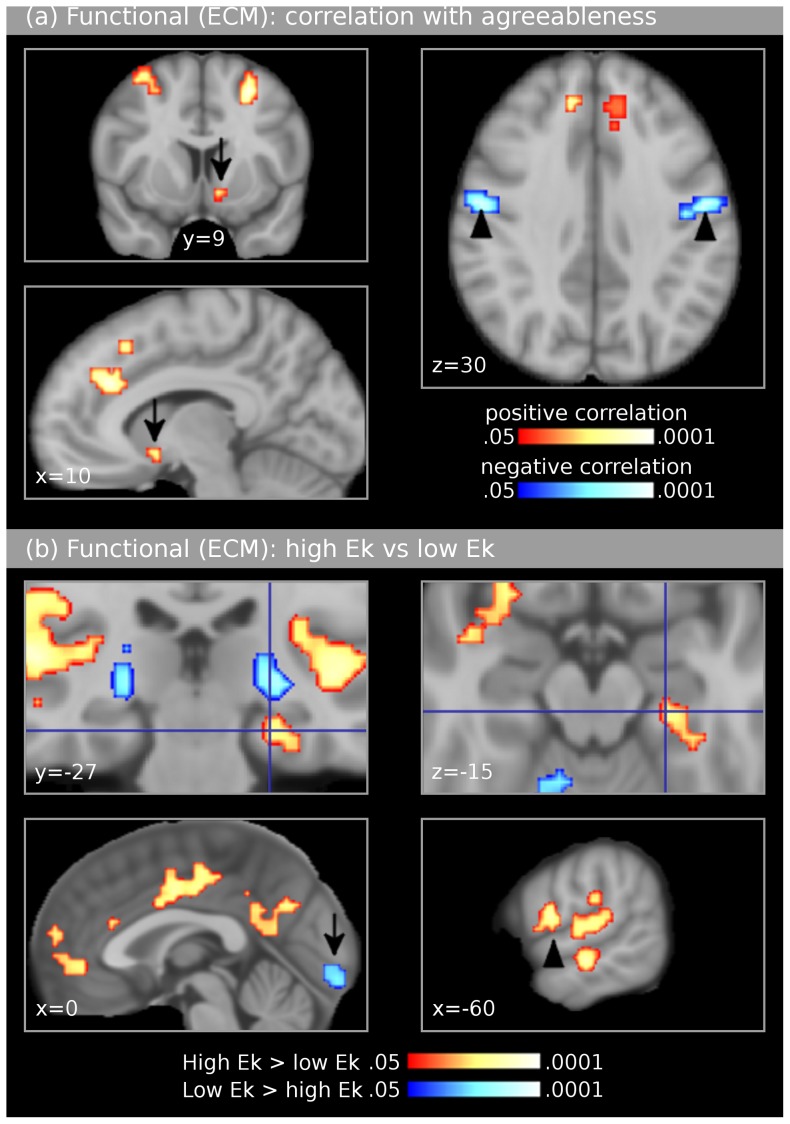
Experiment 1: Functional neuroimaging data (Eigenvector Centrality Mapping).Results were controlled for age and gender, and corrected for multiple comparisons (p<.05). Images are shown in neurological convention. The upper panel (a) shows results of correlations of Eigenvector Centrality Maps (ECMs) with agreeableness scores. For each participant, one ECM was computed for the entire fMRI session. Positive correlations (shown in red-yellow colours) were found in the posterior superior frontal sulcus bilaterally (upper left image), the ventral striatum/nucleus accumbens (arrows in left upper and lower image), and in the anterior cingulate cortex (lower left image). Negative correlations (shown in blue) were observed in the central sulcus (arrowheads in right image). The bottom panel (b) shows the comparison of ECMs between groups of participants with higher and lower E
κ values. Individuals with higher E
κ (taken to reflect higher tender emotionality) showed higher centrality values in the subiculum of the right hippocampal formation (crosshairs in upper images), in the auditory cortex bilaterally, in both anterior and posterior cingulate cortex (lower left image), the anterior fronto-median cortex (lower left image), and the Rolandic operculum (arrowhead in lower right image). The group with lower E
κ showed higher centrality values in the lateral geniculate body bilaterally (blue clusters in upper left image) as well as in the visual cortex (V1, blue cluster in lower left image).